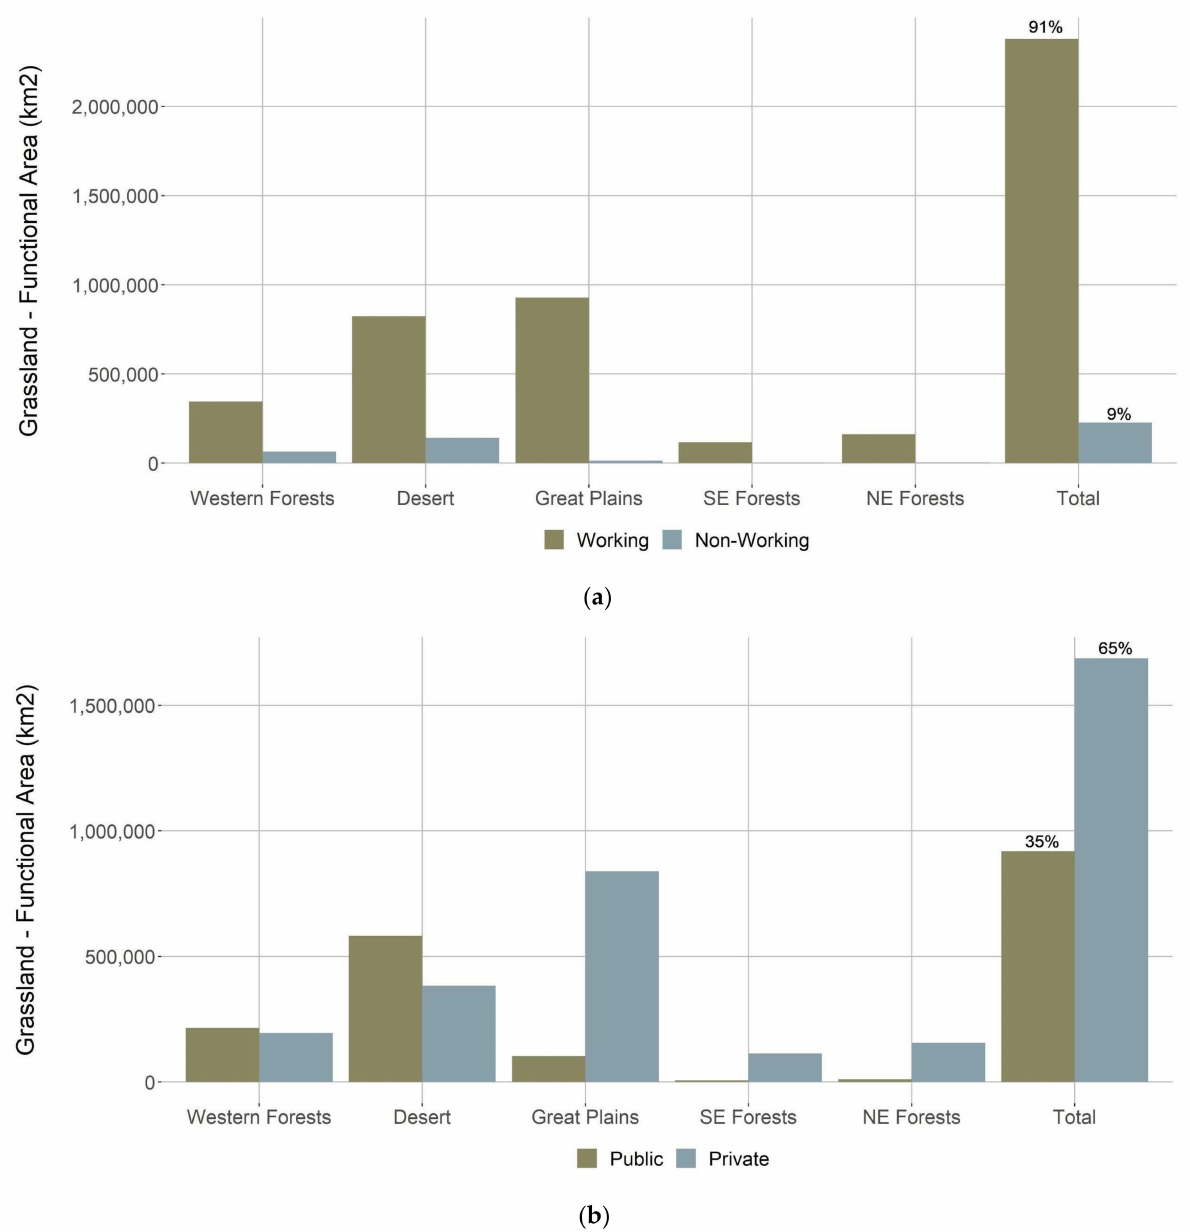
Figure 9. ( a ) The area of functional Grassland Habitat on working vs. non-working lands by ecoregion. ( b ) The area of functional Grassland Habitat in private ownership by